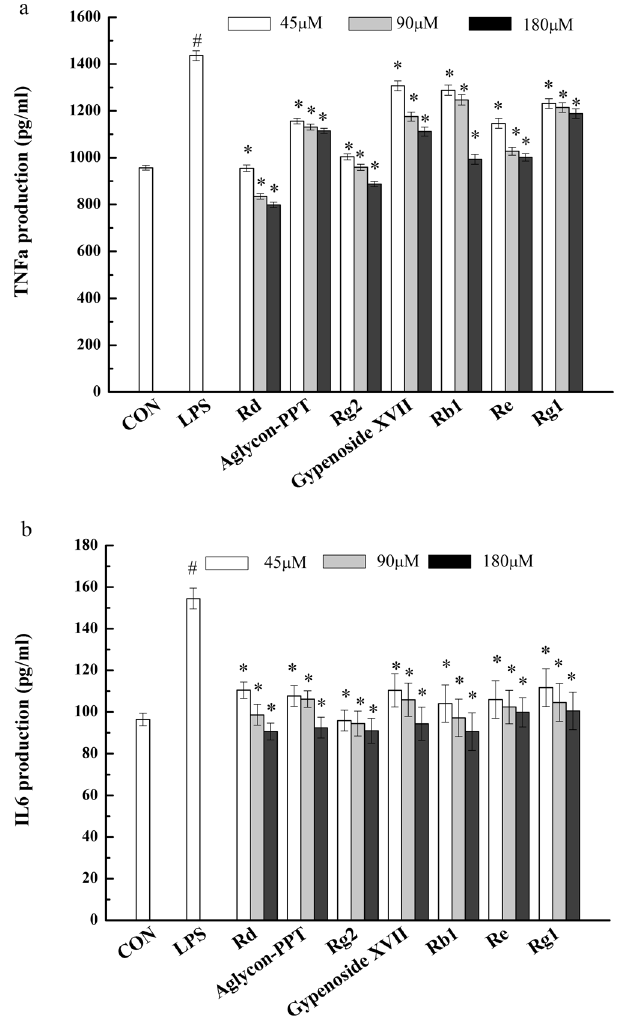
Figure 4. Effects of ginsenosides on protein productions of pro-inflammatory cytokines TNF- α ( a ) and IL-6 ( b ) in LPS-stimulated RAW 264.7 cells. The data are means ± SD (n = 3). # p < 0.05 vs. the LPS-free control; * p < 0.05 vs. the LPS treated